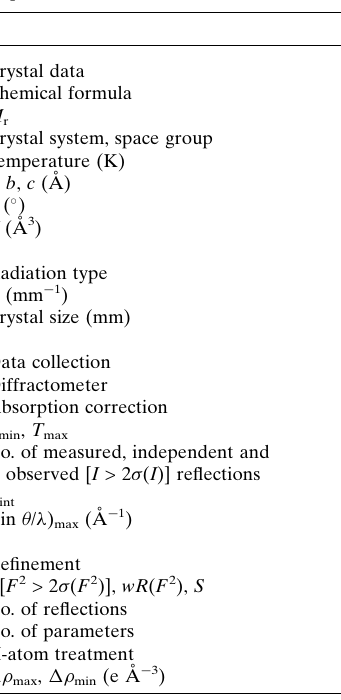
Table 3 Experimental